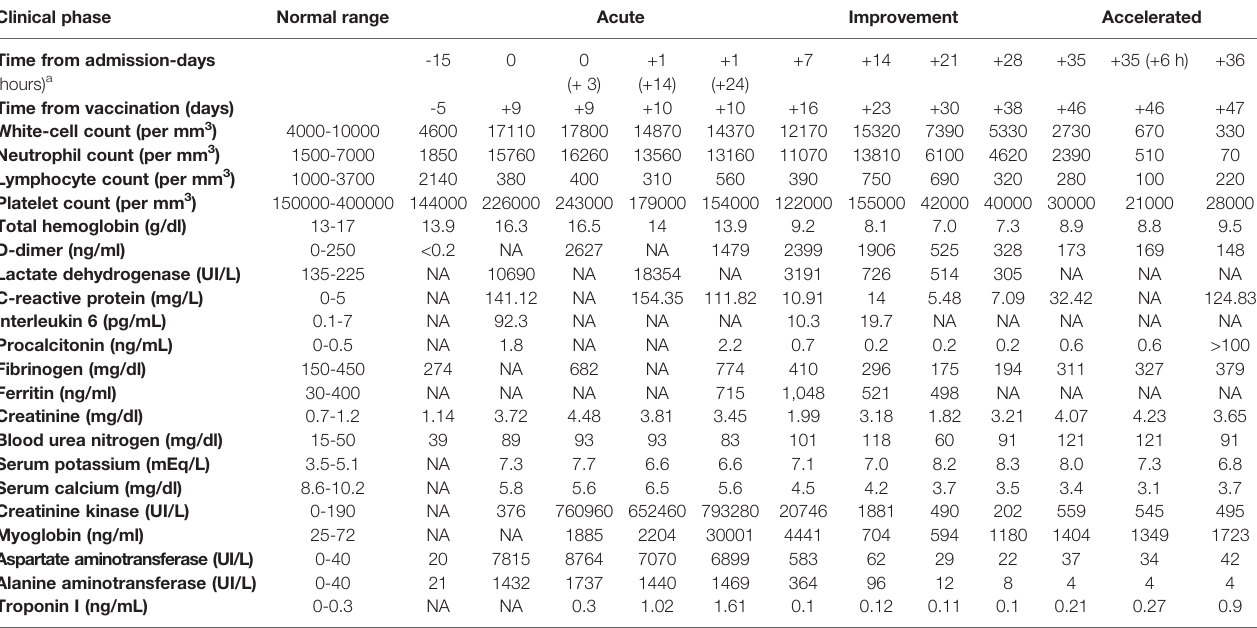
TABLE 1 | Main laboratory features of the patient.